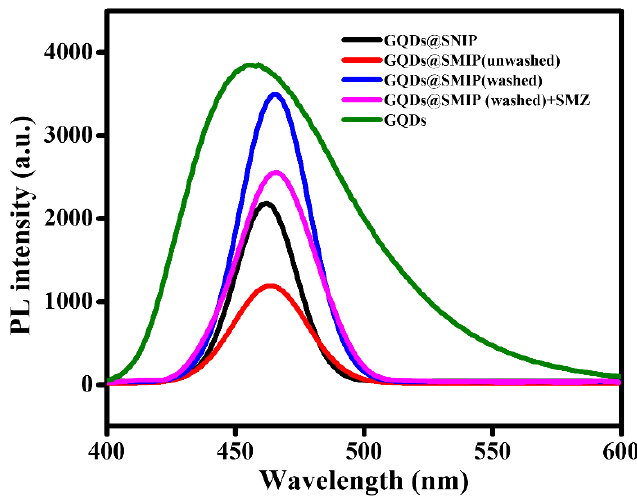
Figure 1. Fluorescence spectra of a GQD suspension (6.85 mg/mL in water solvent), GQDs@SNIP, GQDs@SMIP (unwashed), GQDs@SMIP (washed), washed GQDs@SMIP in the presence of SMZ at 50 µM concentration under the excitation wavelength of 370 nm. The concentrations of GQDs@SNIP and GQDs@SMIP were the same at 5 mg/mL in water solvent.